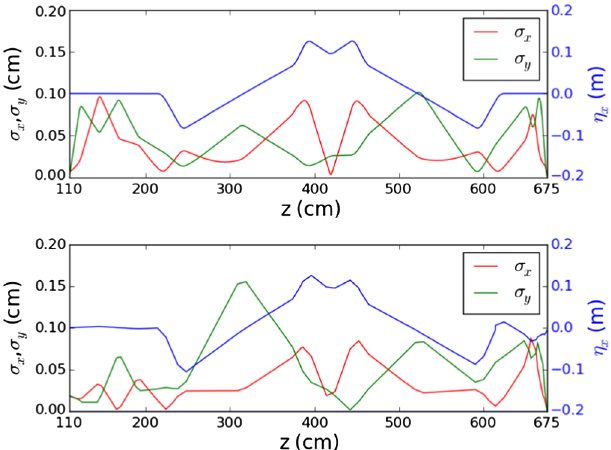
FIG. 5. The rms beam size and dispersion function from the first matching quadrupole magnet to the last focusing quadrupole magnet without space charge effects from O PTI M (top plot) and with space charge effects from PARMELA (bottom plot). To calculate the redefined dispersion (the detailed discussion about the redefined dispersion can be found in Sec. IVA) in the bottom plot, we select those particles whose energy deviation upstream of the first matching quadrupole magnet (i.e., qD 6 ) at 110 cm is in the range 0.7% – 0.8%. To calculate the redefined beta functions (actually, it is the beam size in the plot) in the bottom plot, we select those particles whose emittance upstream of the first matching quadrupole magnet (i.e., qD 6 ) at 110 cm is smaller than 0.1 mm